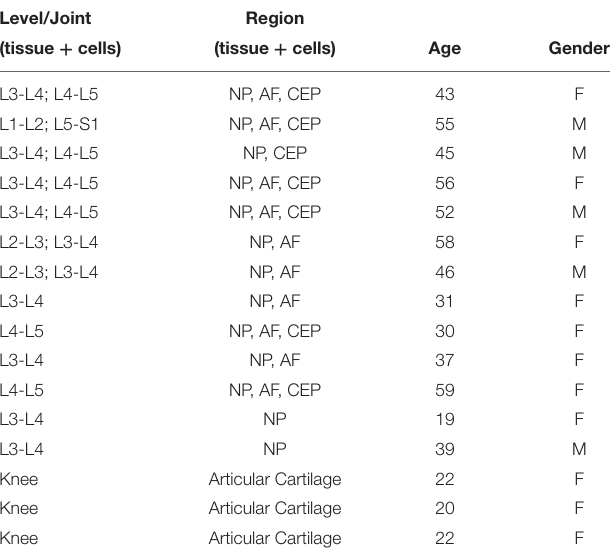
TABLE 1 | Human tissue and